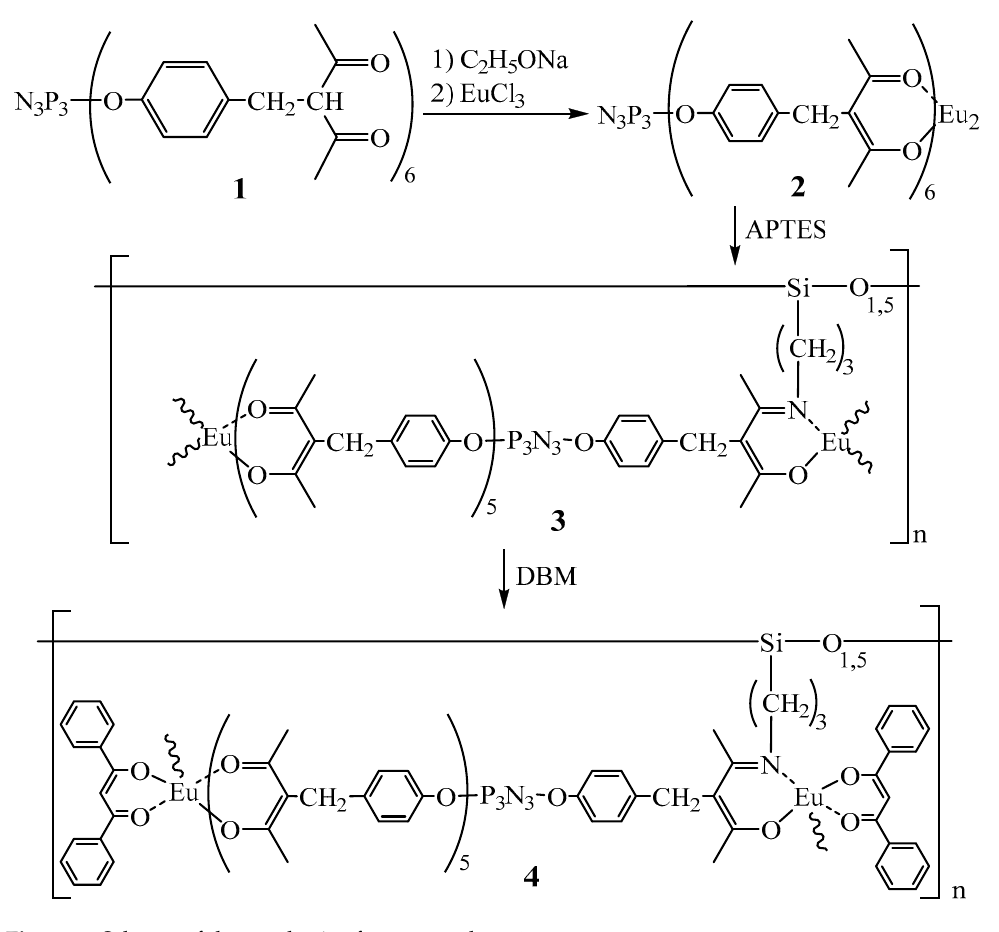
Figure 1. Scheme of the synthesis of compounds 1 – 4 .